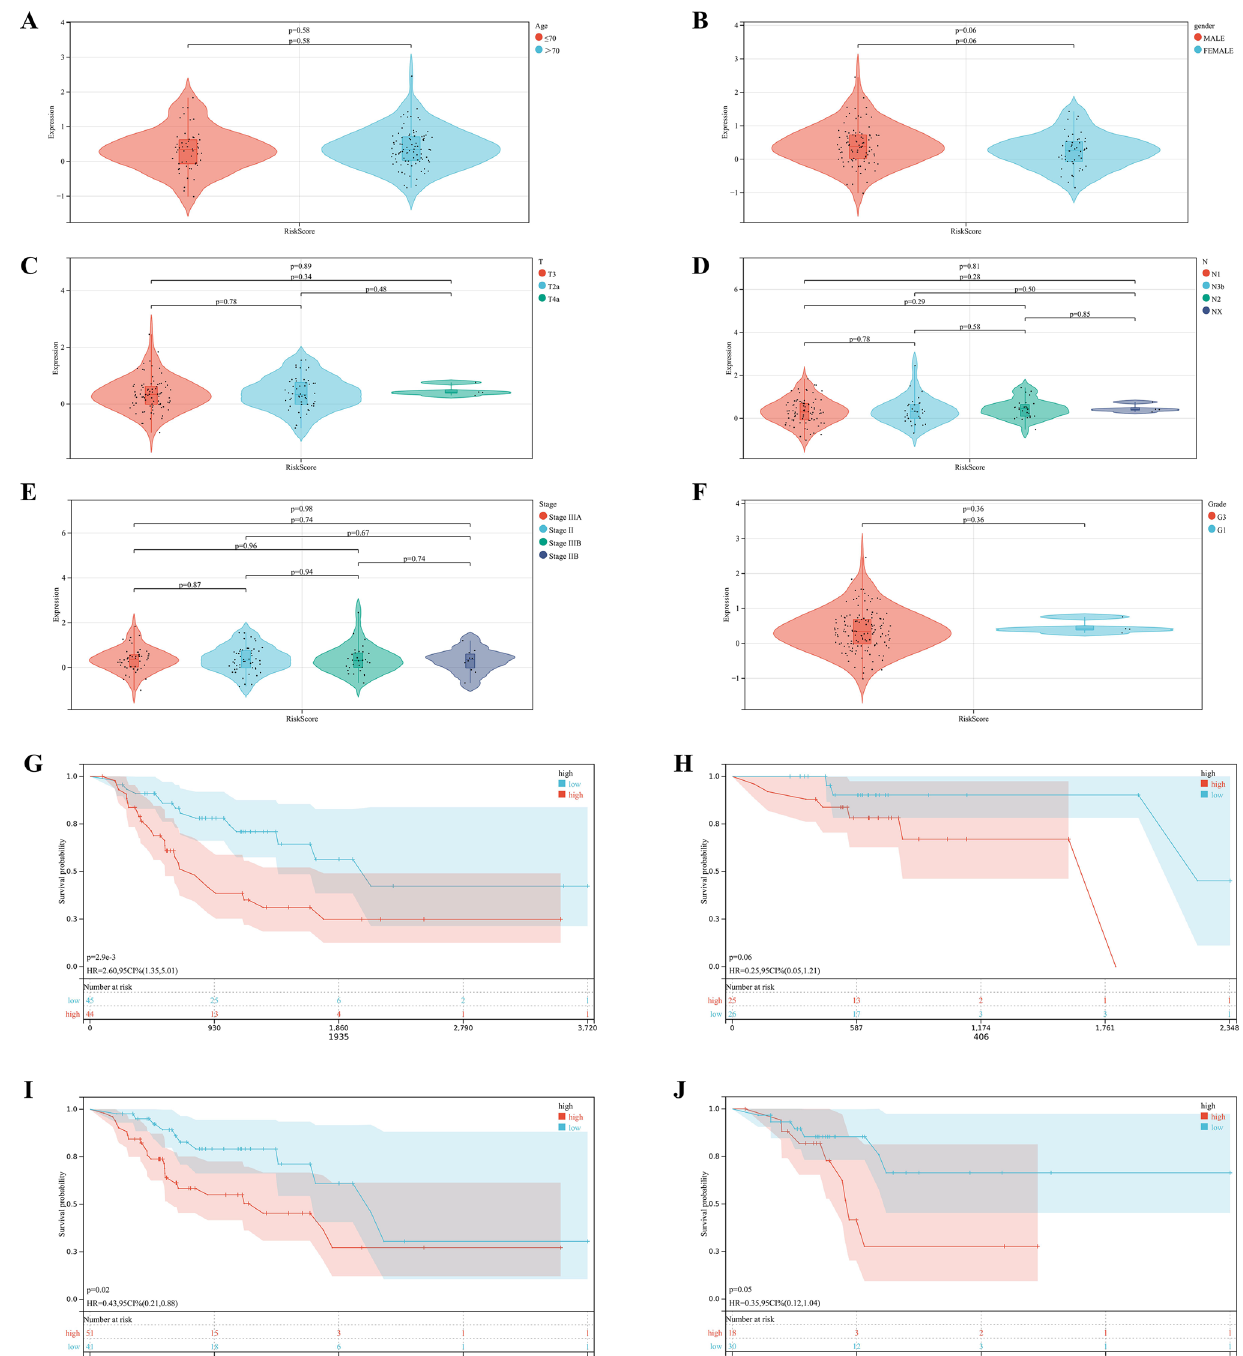
Figure 7. Association of risk score and clinical characteristics. Differences in risk scores among ( A ) Age, ( B ) Gender, ( C ) T, ( D ) N, ( E ) Stage, and ( F ) Grade. ( G , H ) Survival curve of GC patients regrouped according to age. ( I , J ) Survival curve of GC patients regrouped according to